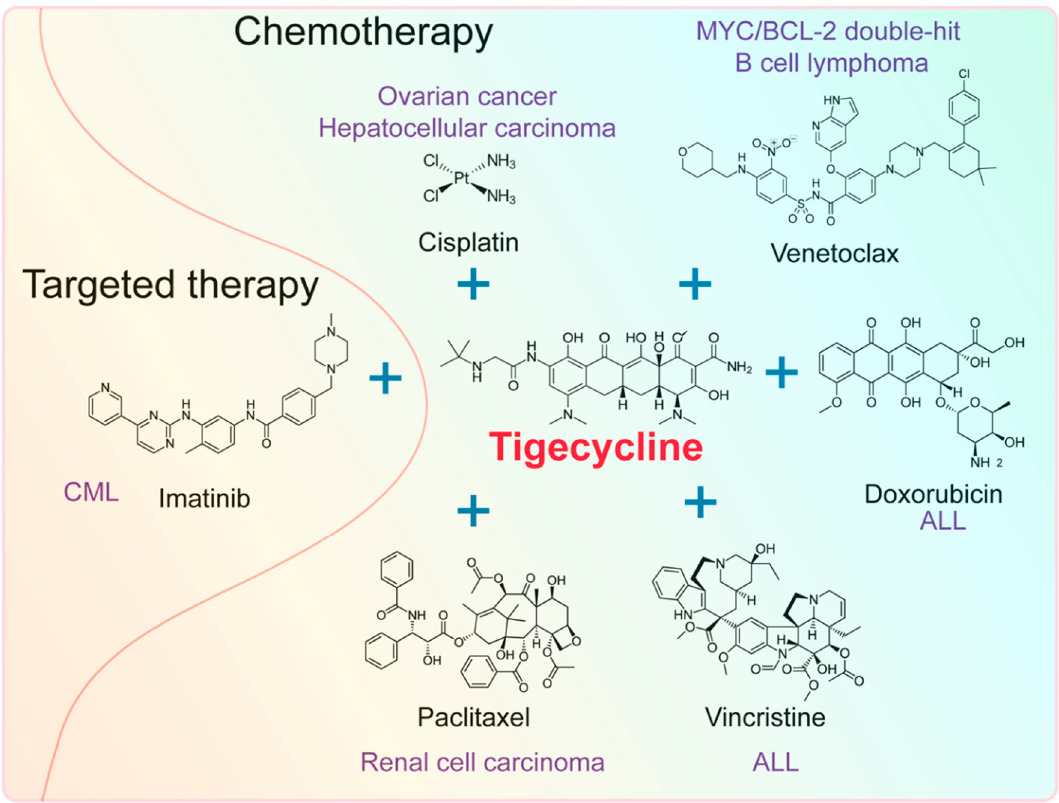
Figure 4. Tigecycline promotes susceptibility of tumors to chemotherapy and targeted therapy. ALL, acute lymphoblastic leukemia; CML, chronic myeloid leukemia.